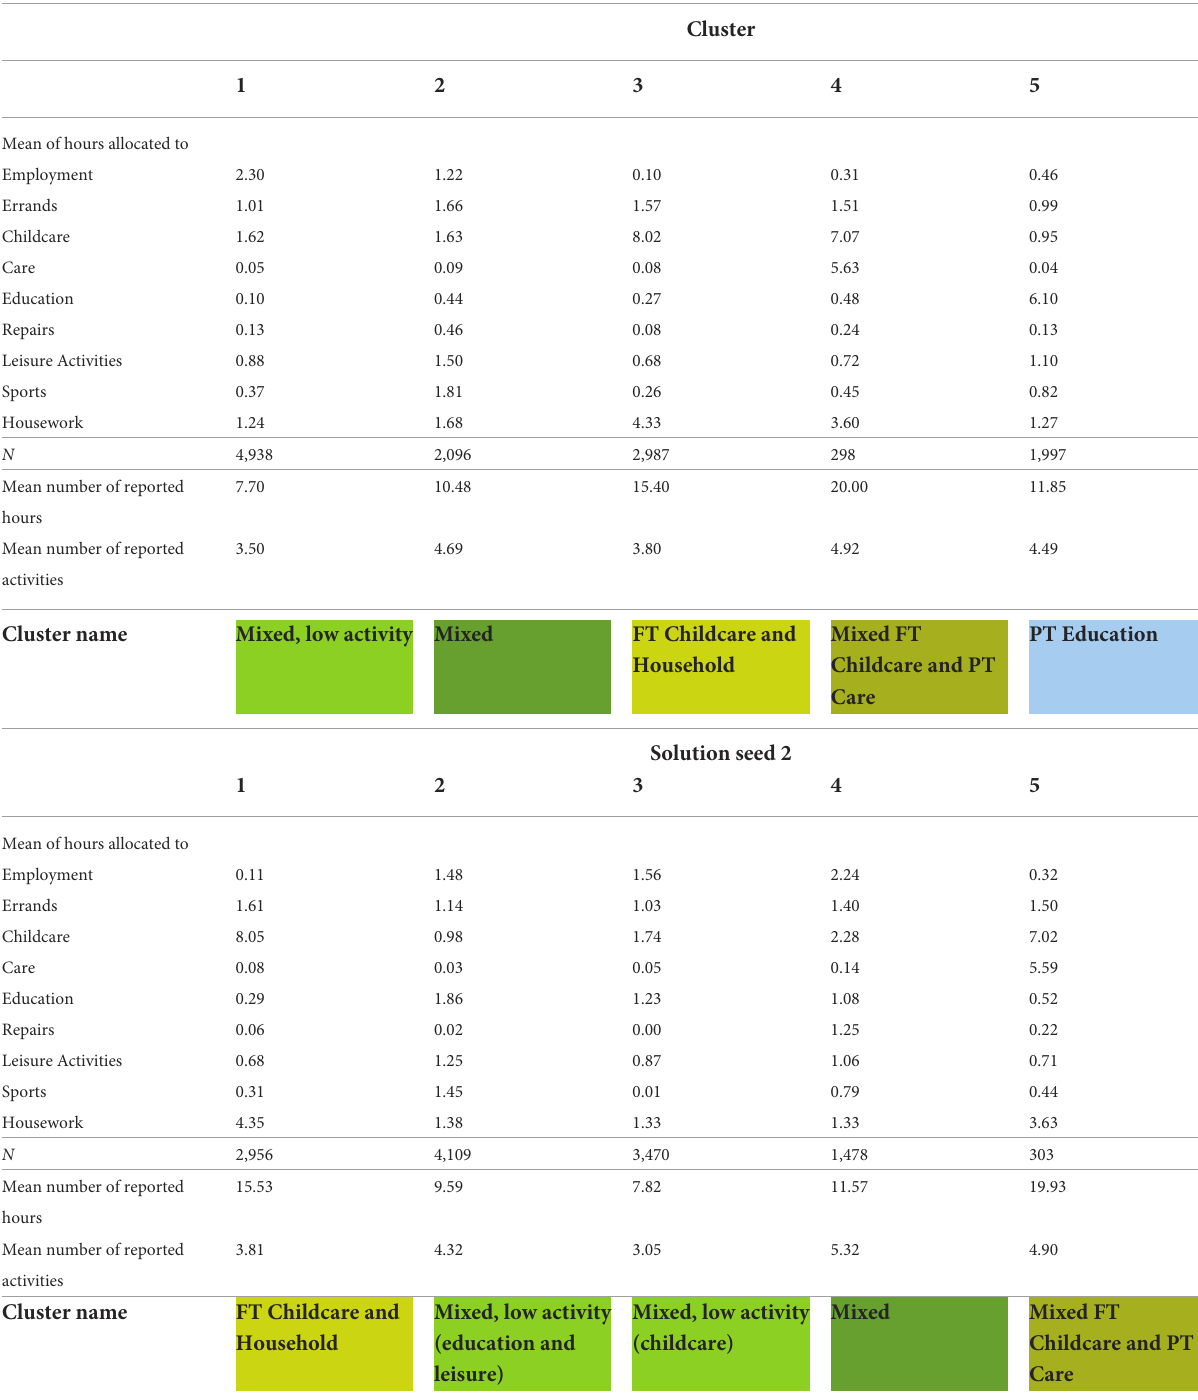
TABLE 2 Mean hours invested in activities by cluster